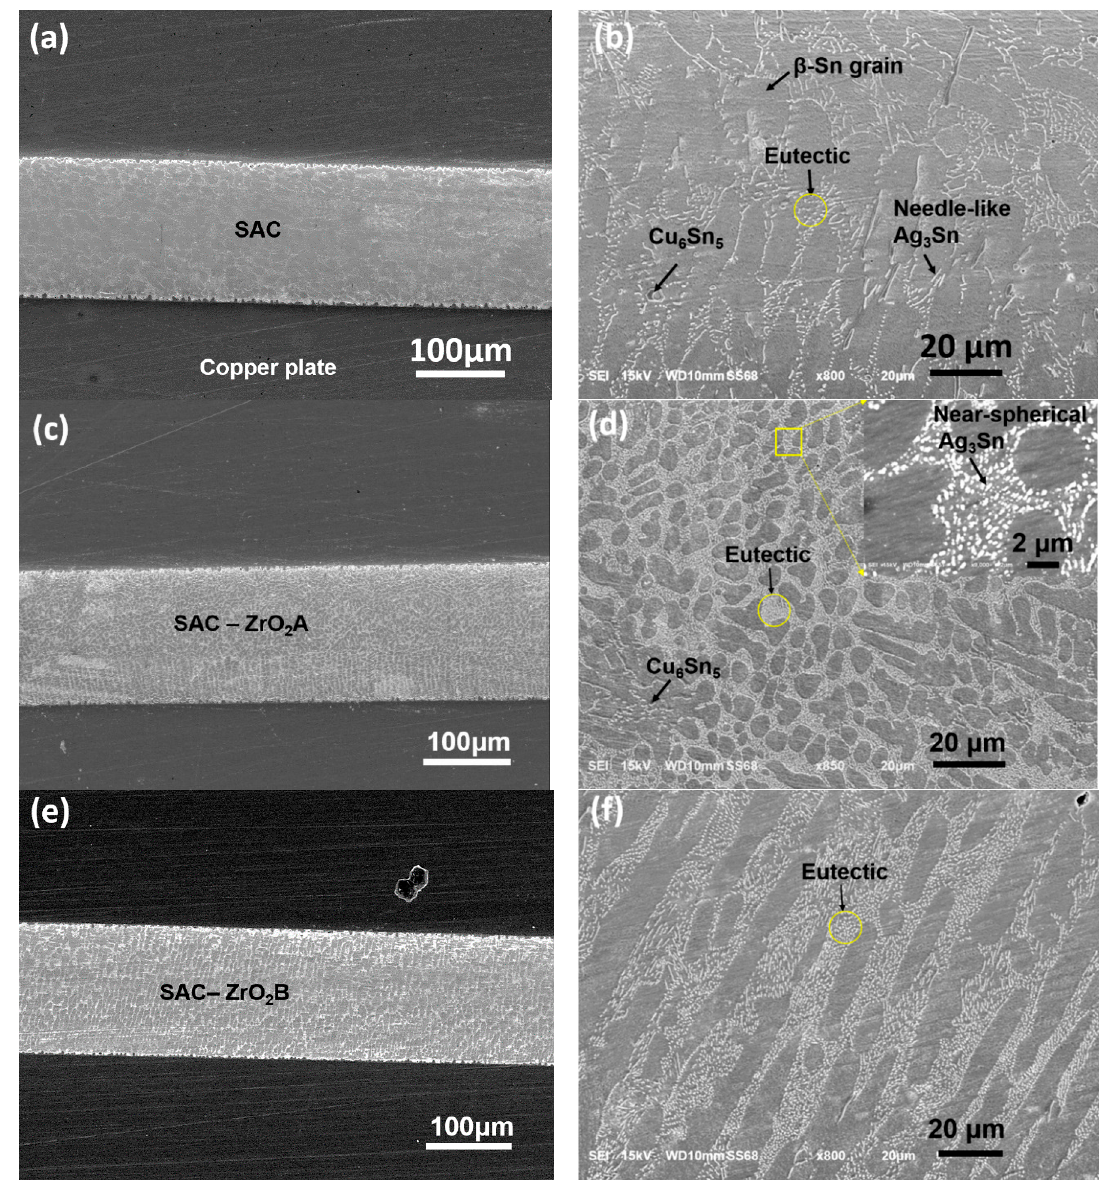
Figure 3. Scanning electron microscope (SEM) micrograph of as-reflowed ( a ) SAC 305/Cu joint and ( b ) the corresponding microstructure, ( c ) SAC 305-ZrO 2 A/Cu joint and ( d ) the corresponding microstructure, ( e ) SAC 305-ZrO 2 B/Cu joint and ( f ) the corresponding microstructure .